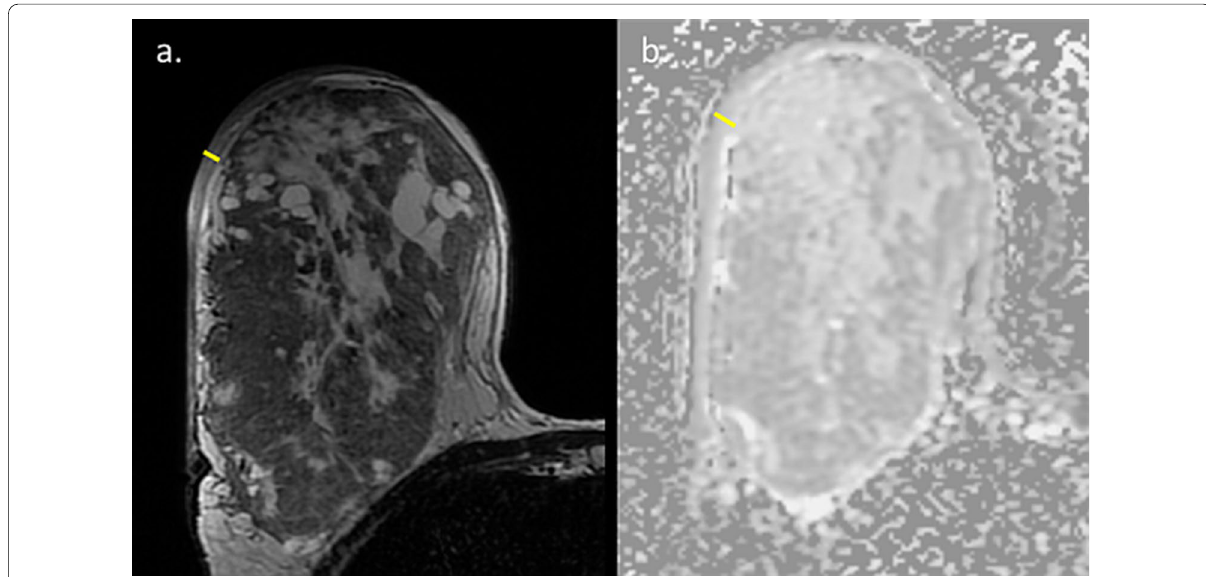
Fig. 8 Mastitis. Unenhanced MR images of 37‑year‑old pregnant patient with refractory mastitis are presented. The patient presented with breast edema, erythema and pruritus and blinded subcutaneous punch biopsies revealed adenosis on pathology. Because of continuous symptoms despite treatment, we were requested to perform MRI without contrast injection to rule out underlying inflammatory carcinoma. T2 weighted image revealed thickened skin ( a ) (yellow line), while no focal restriction was noted on ADC map ( b )